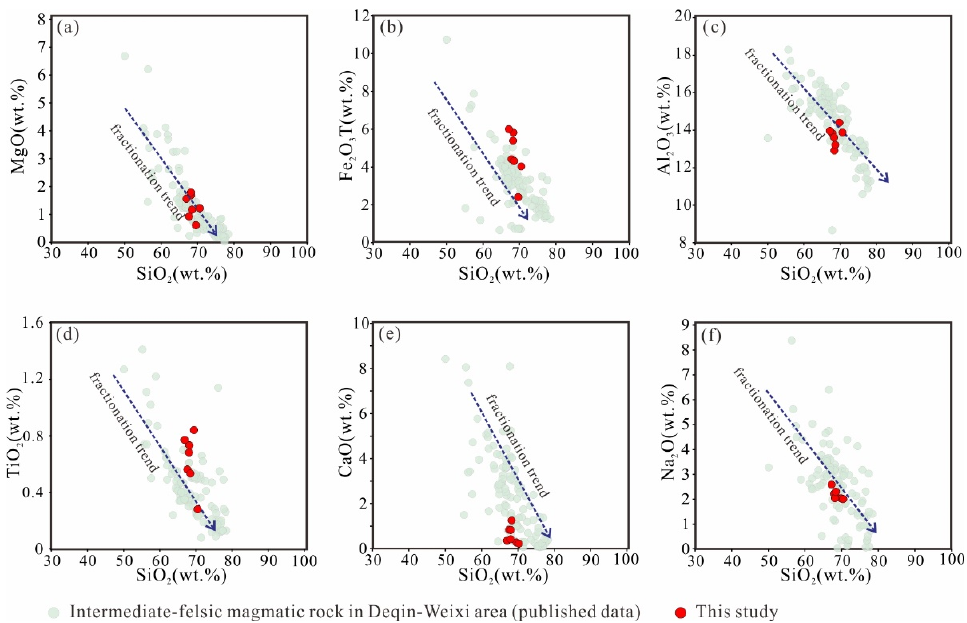
Figure 12. Harker diagrams for the Deqin–Weixi–Madeng intermediate-felsic magmatic rocks. (a) SiO 2 vs. MgO; (b) SiO 2 vs. Fe 2 O 3T ; (c) SiO 2 vs. Al 2 O 3 ; (d) SiO 2 vs. TiO 2 ; (e) SiO 2 vs. CaO; (f) SiO 2 vs. Na 2 O. Data source: [8,10–12,15,43].